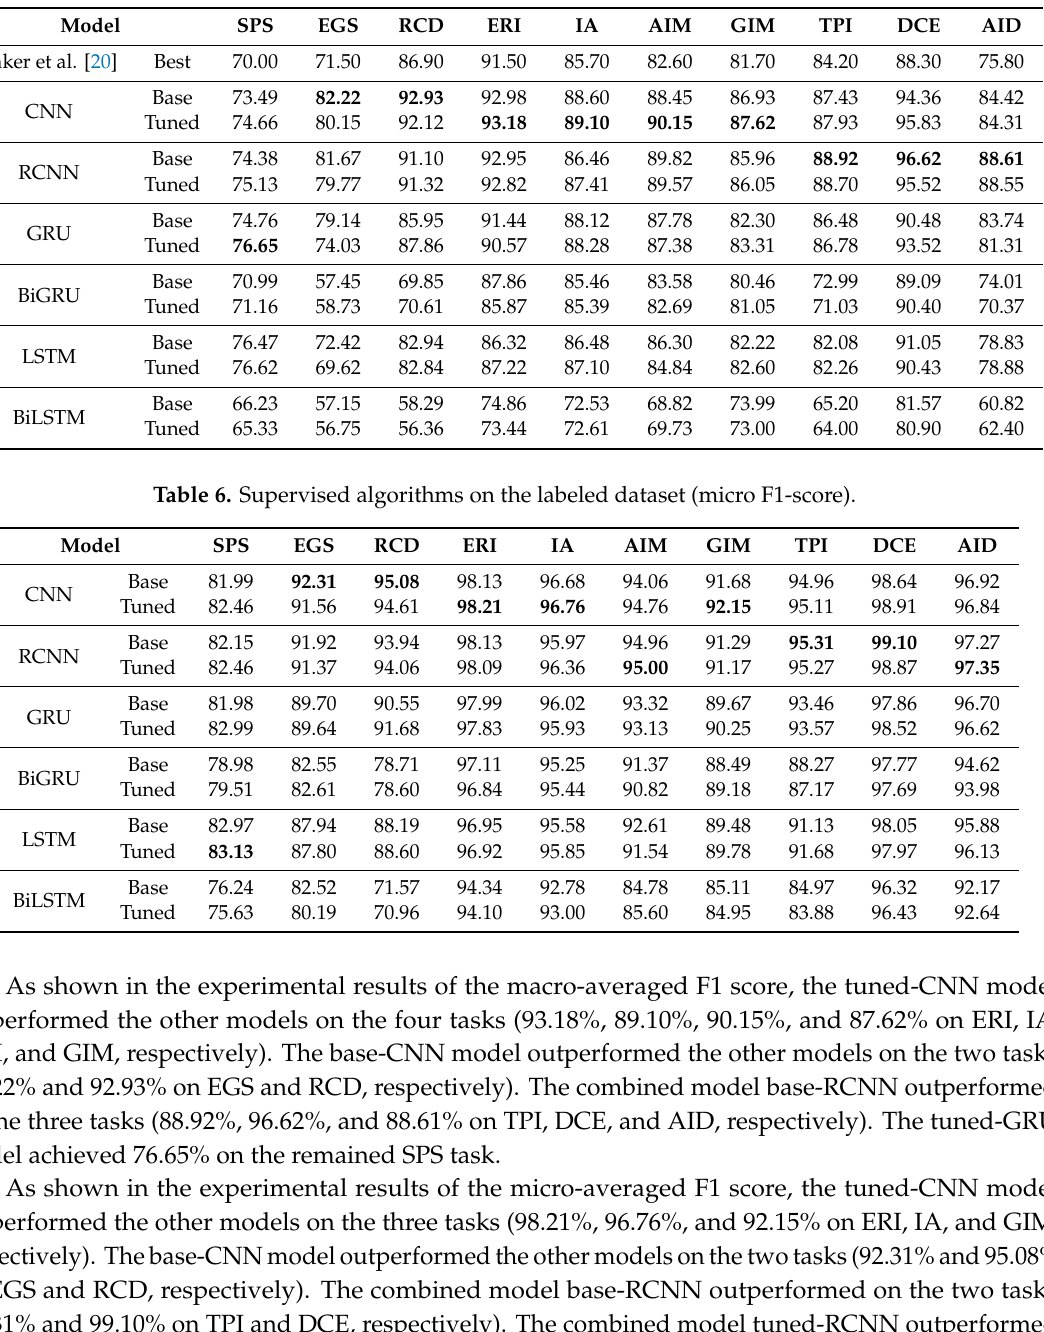
Table 5. Supervised algorithms on the labeled dataset (macro F1-score).